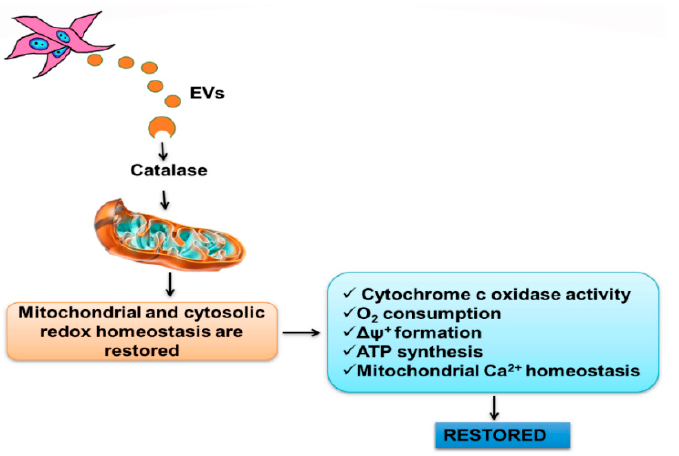
Figure 9. Suppressing the excess of O 2 •− : Proposed mechanisms for the rapid effects of EVs (24 h of reperfusion after renal ischemia). Mesenchymal cells (MSCs) secrete EVs that, after subcapsular administration and diffusion into the renal parenchyma [10], reach the tubular segments injured by I/R. By releasing several factors, including the catalase they carry [58], they contribute to maintaining the normal local redox state existing in the absence of injury. With mitochondrial and cytoplasmic redox homeostasis restored, the mitochondrial processes required for ATP synthesis are preserved and, therefore, the appropriate ATP supply is preserved for the transport demands and maintenance of tubular